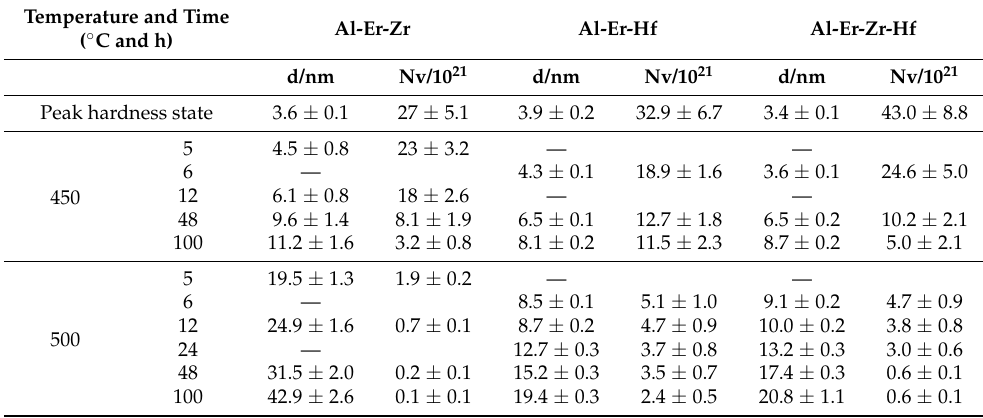
Table 1. The average diameter and number density of precipitates after various annealing. Temperature and Time ( ◦ C and